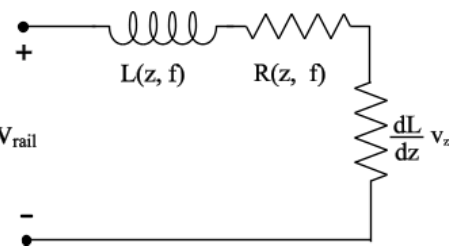
Figure 7. Basic equivalent lumped parameter circuit of a rail launcher. The presence of f (frequency) among the independent variables means that the circuit parameters are function of the rate of change of the electromagnetic